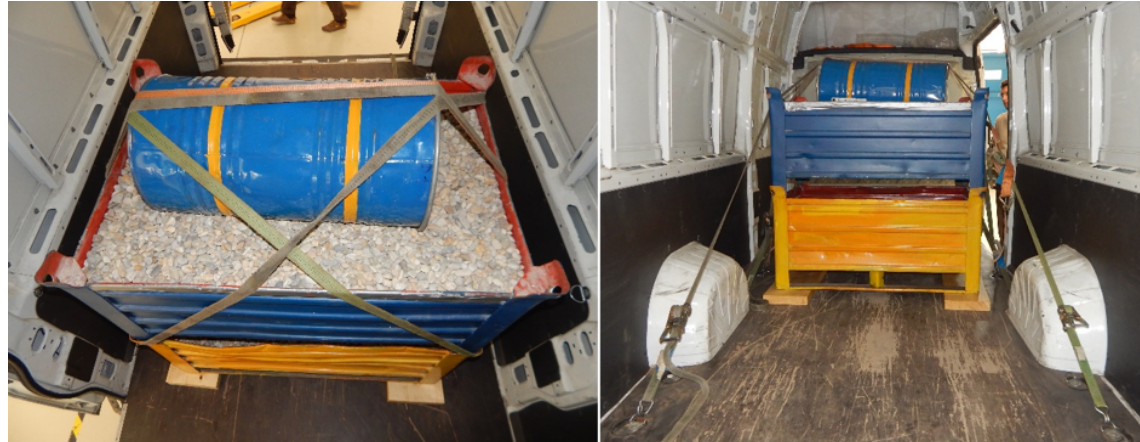
Figure 3: Securing of the 1000 kg load with high COG. Source: Authors